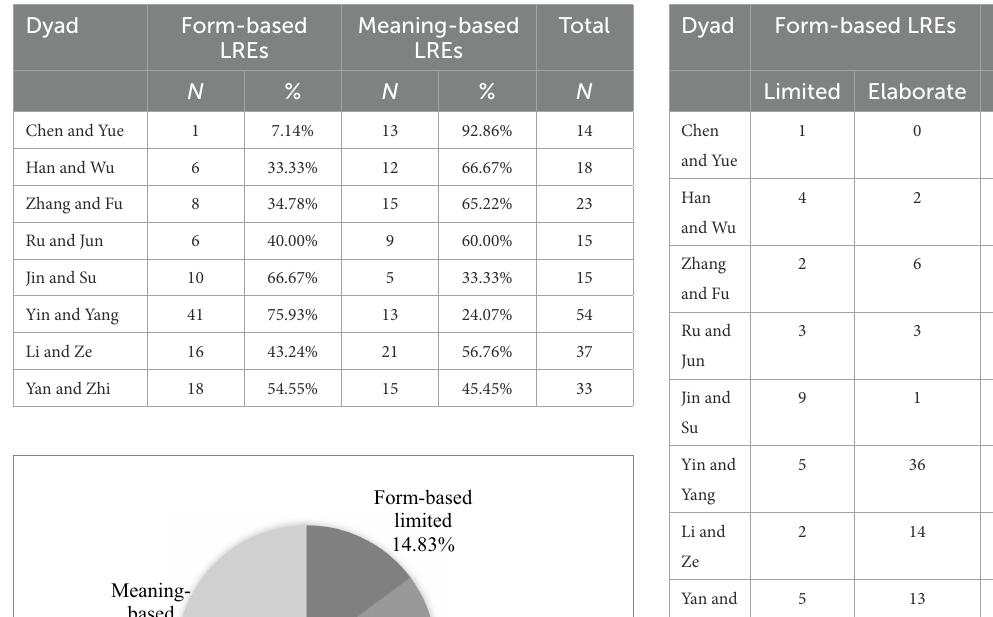
TABLE 3 Results for form-based and meaning-based LREs. TABLE 4 Results for elaborate and limited